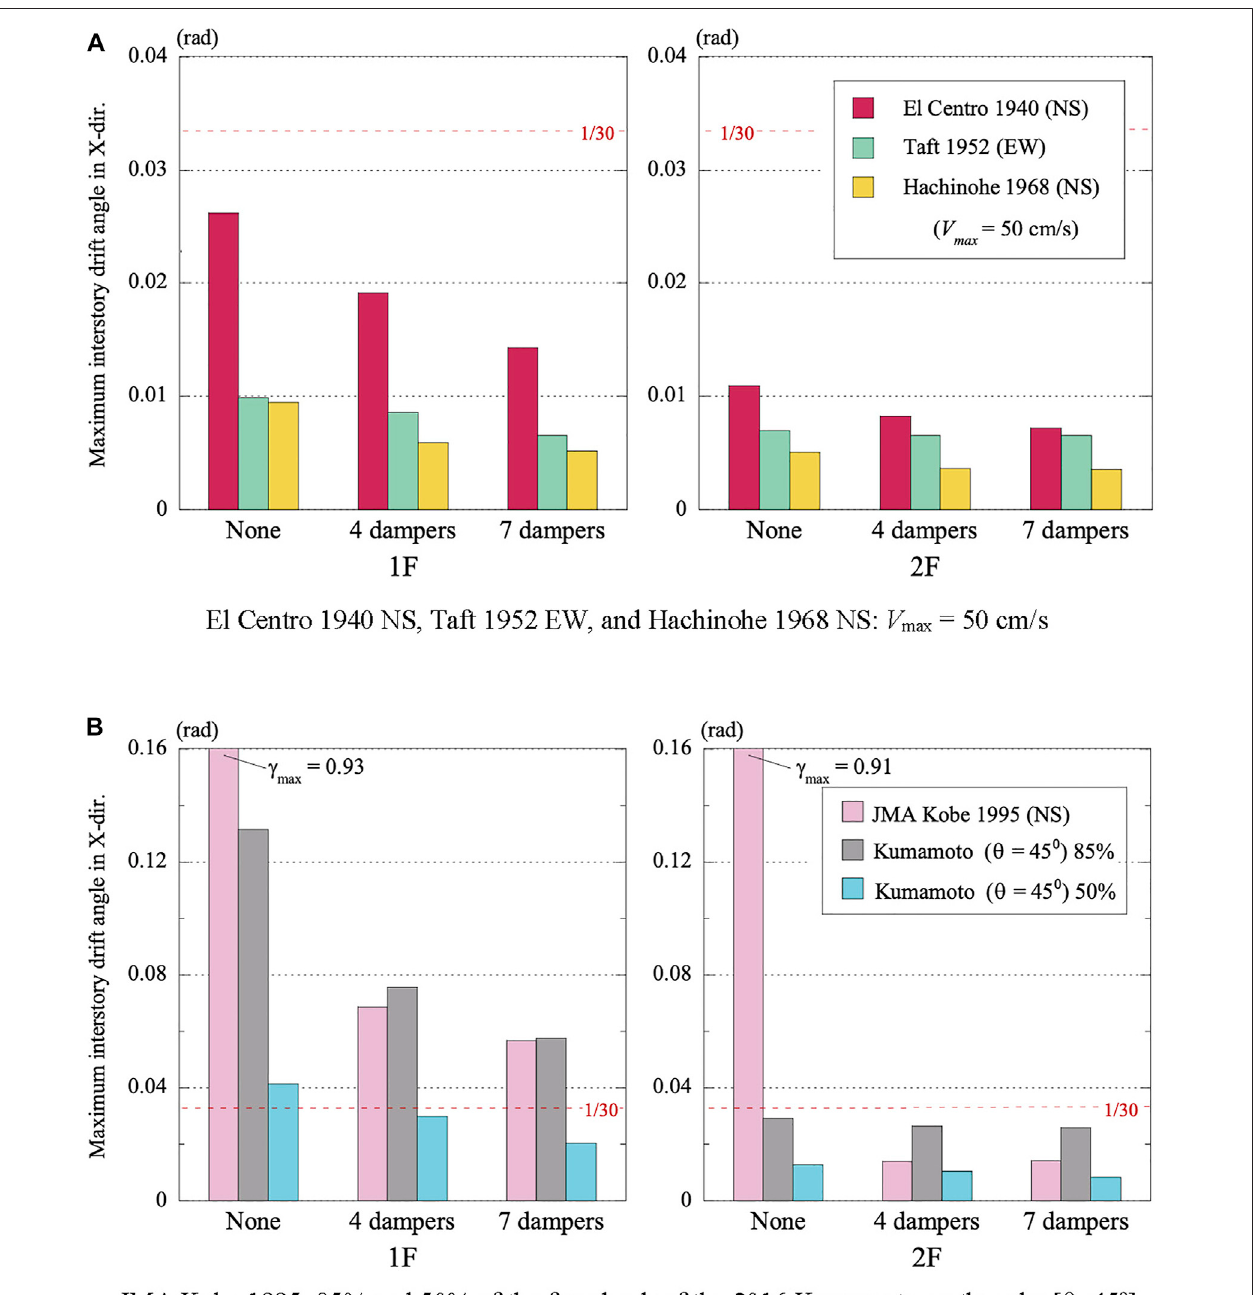
FIGURE 12 | Maximum 1st- and 2nd-story drift angles of column A of the timber house. with and without dampers. (A) El Centro 1940 NS, Taft 1952 EW, and Hachinohe 1968 NS: Vmax (cid:1) 50 cm/s. (B) JMA Kobe 1995, 85% and 50% of the foreshock of the 2016 Kumamoto earthquake [ θ (cid:1) 45o].